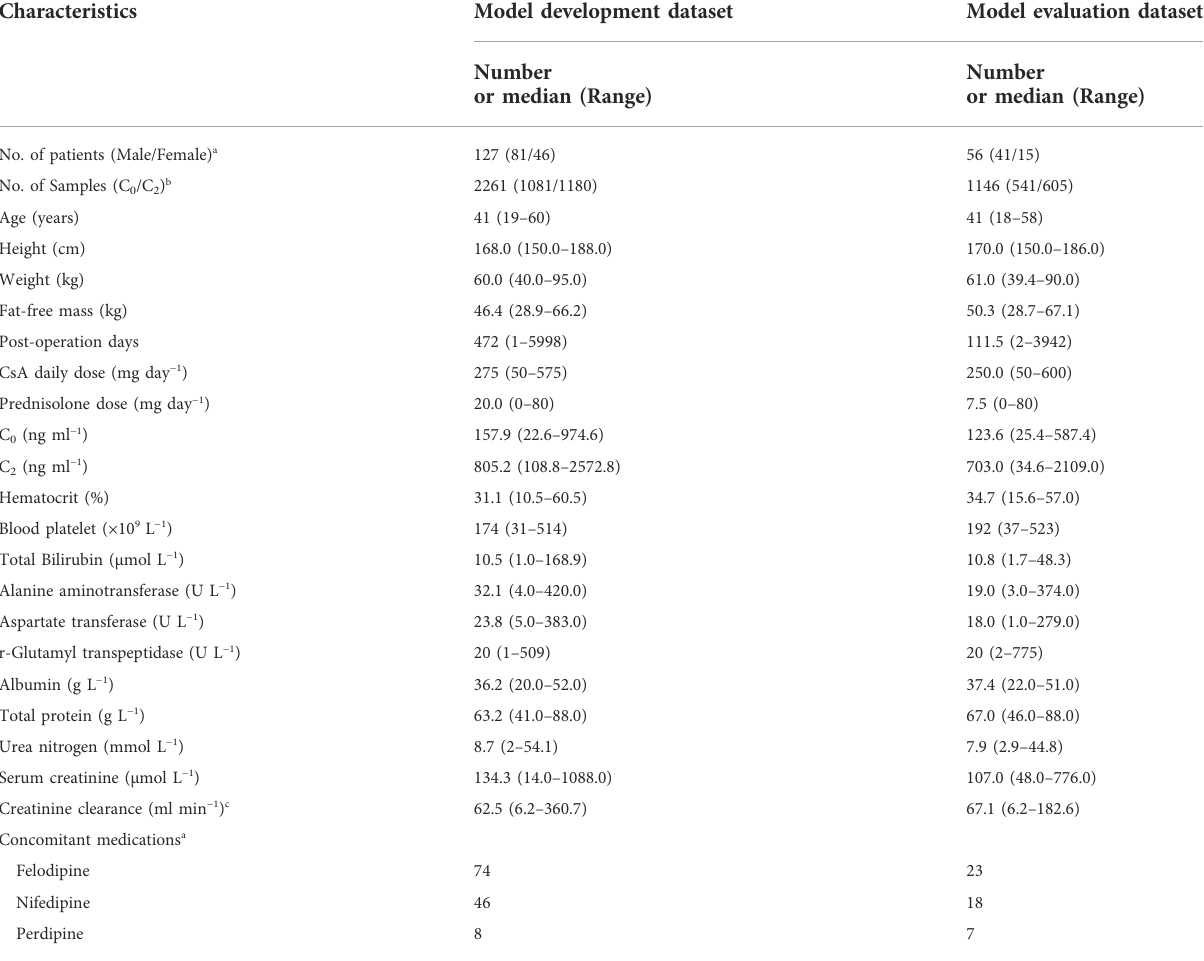
TABLE 1 Patients demographics used to develop and evaluate